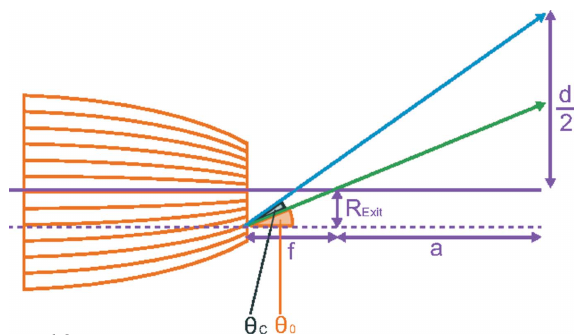
Figure 14 Sketch of the divergence far from the focal distance.